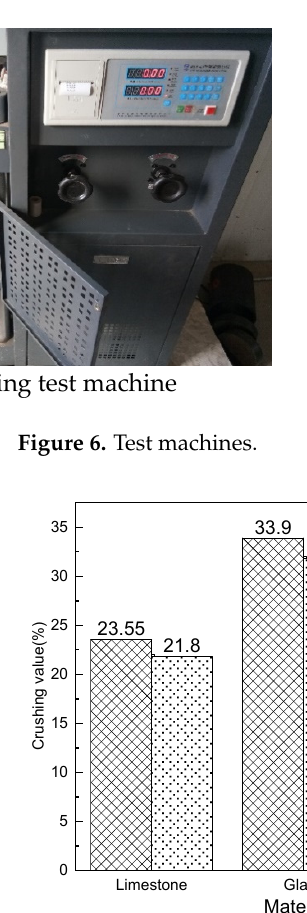
Figure 7. Mechanical properties of aggregates. Table 3. Local standards of mechanical